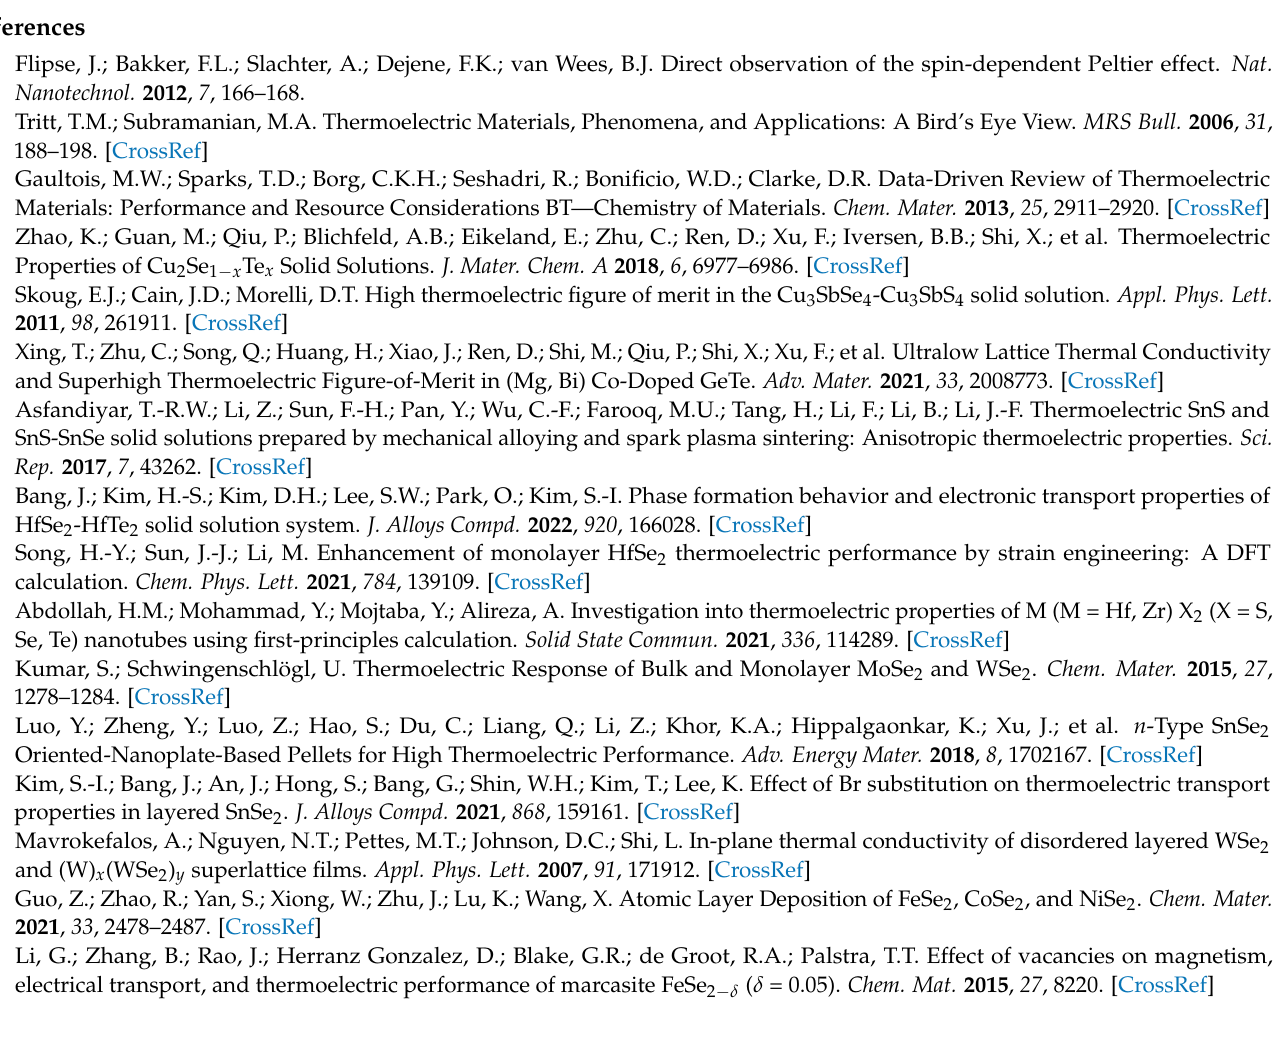
the series of FeSe 2 − x S x ( x = 0, 0.2, 0.4 and 0.6) samples using Goldsmid-Sharp empirical formular; Table S1: The relative peak intensities for (111), (012), (121), (011), (200) and (103) planes for FeSe 2 − x S x ( x = 0, 0.2, 0.4, and 0.6) in the X-ray diffraction data; Table S2: Atomic ratios measured by EDS-SEM for FeSe 2 − x S x ( x = 0, 0.2, 0.4, 0.6 and 0.8). References [16,28] are cited in the supplementary